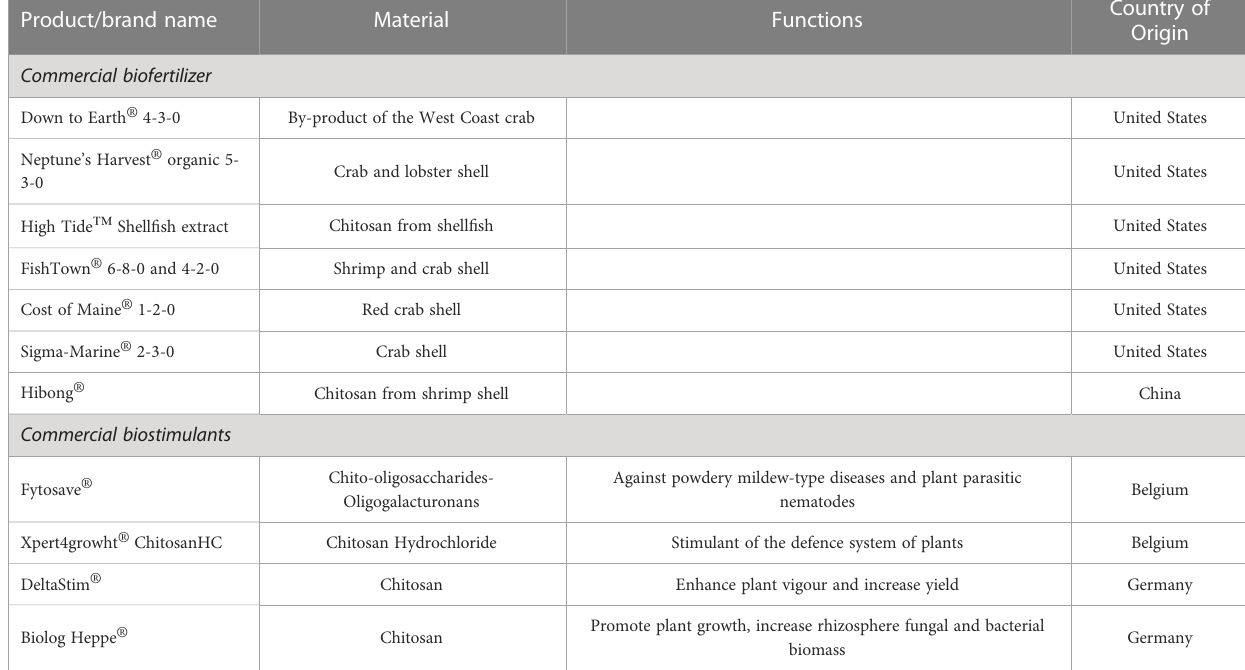
TABLE 2 Examples of commercial biofertilisers, biostimulants and biopesticides produced from crustaceans processing side